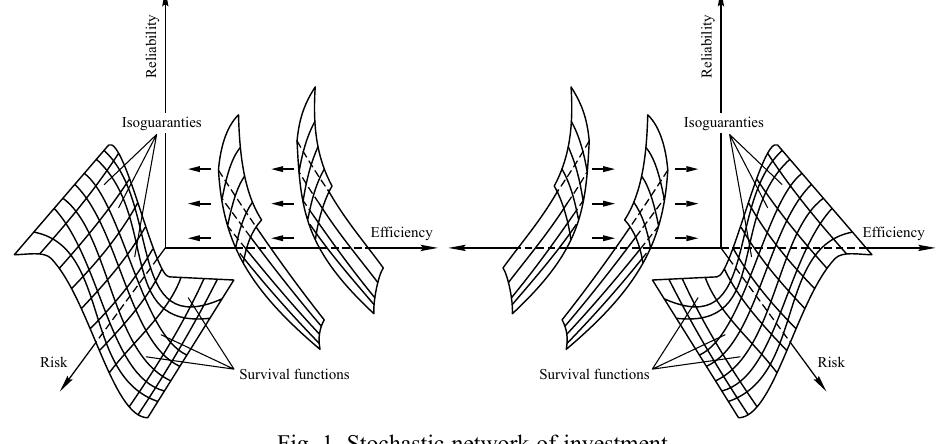
Fig. 1. Stochastic network of